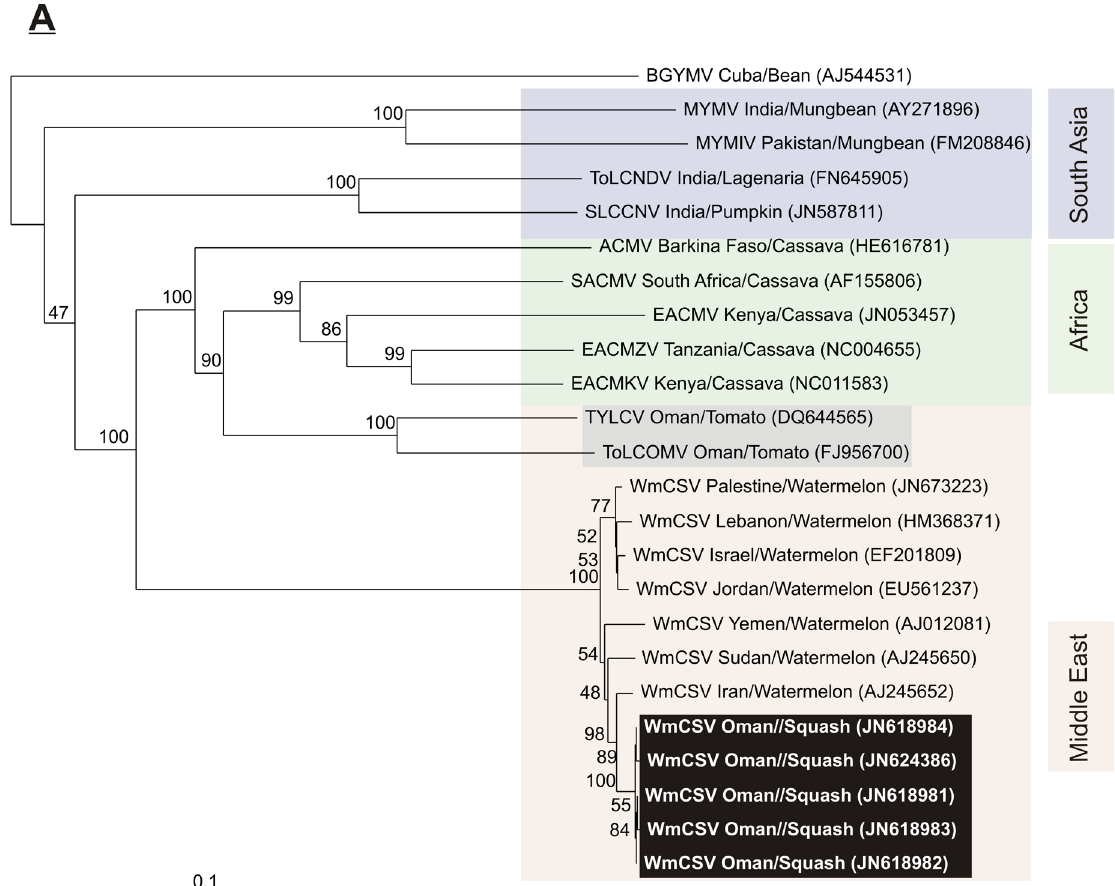
Figure 3. Neighbor joining phylogenetic dendrogram based upon alignments of the sequences of the genomes for DNA A components ( A ) and DNA B components ( B ) of WmCSV and selected other begomoviruses from the databases. In each case the database accession number is given. The numbers at nodes represent percentage bootstrap confidence scores (1000 replicates). The alignment was arbitrarily rooted on outgroup Bean golden yellow mosaic virus (BGYMV), a distantly related begomovirus. Begomovirus acronyms used are Mungbean yellow mosaic virus (MYMV), Mungbean yellow mosaic India virus (MYMIV), Tomato leaf curl New Delhi virus (ToLCNDV), Squash leaf curl China virus (SLCCNV), African cassava mosaic virus (ACMV), South African cassava mosaic virus (SACMV), East African cassava mosaic virus (EACMV), East African cassava mosaic Zanzibar virus (EACMZV), East African cassava mosaic Kenya virus (EACMKV), Tomato yellow leaf curl virus (TYLCV) and Tomato leaf curl Oman virus (ToLCOMV). The isolates characterized here are indicated with white text on black background. Other begomoviruses from Oman are highlighted by a gray background. Additionally the begomoviruses originating from the Middle East, Africa and southern Asia are indicated by colored